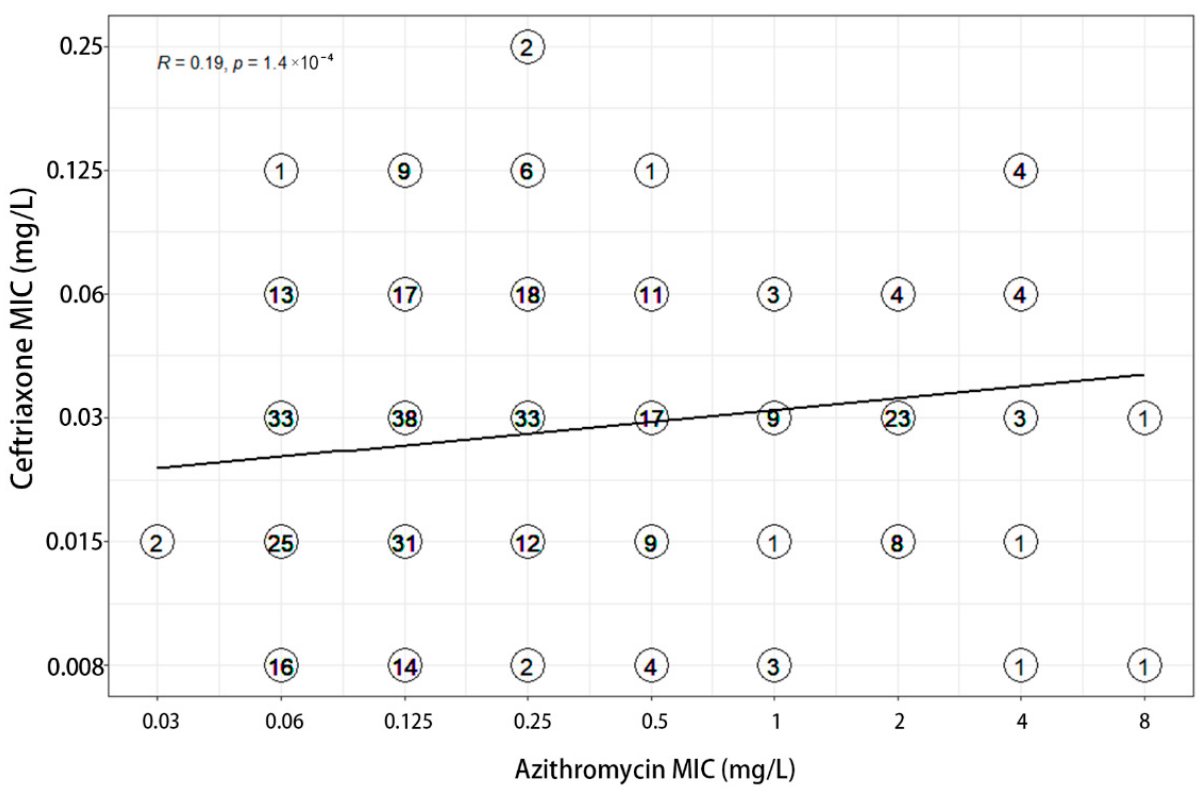
Figure 3. Correlation between MICs to azithromycin and ceftriaxone.